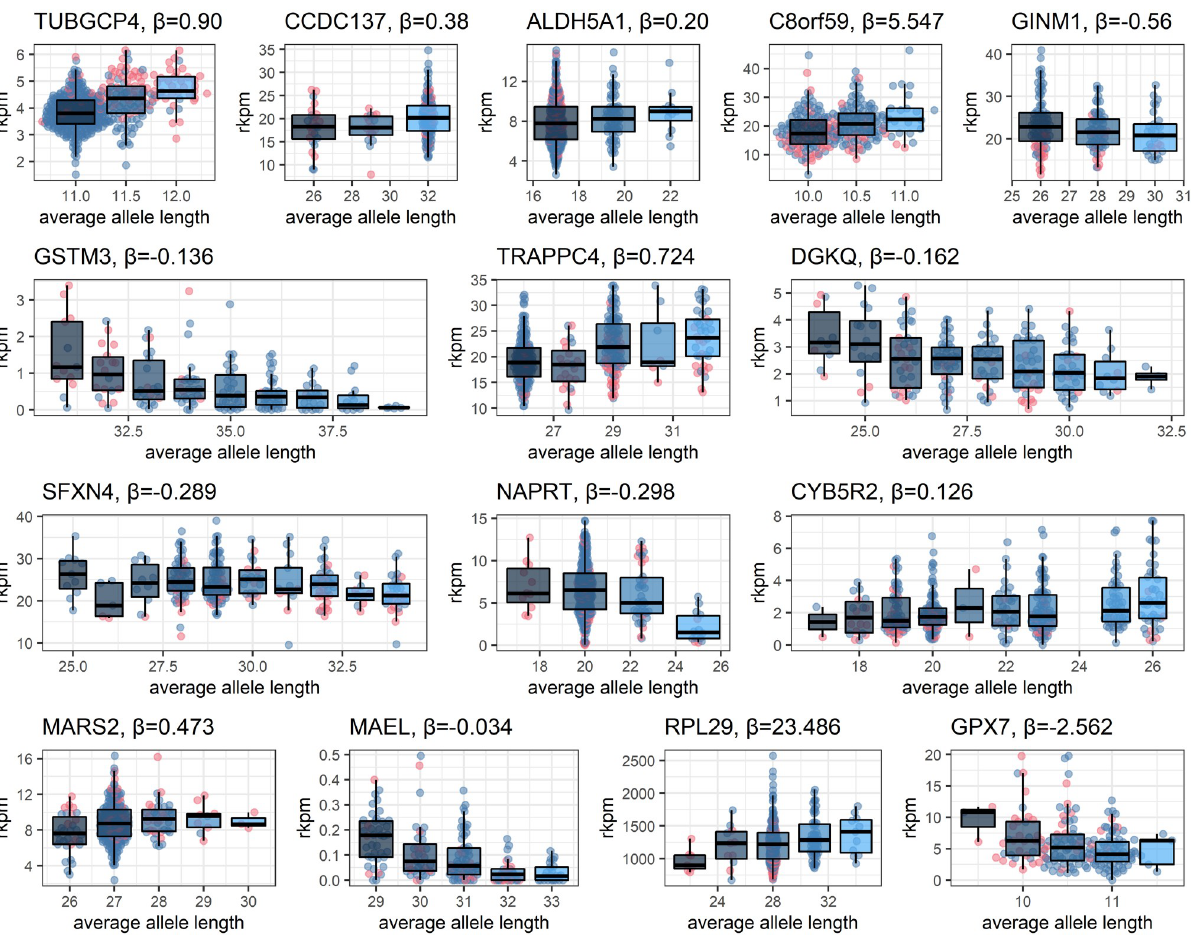
Fig 4. Array length polymorphisms for 15 microsatellites correlate with gene expression. Each gene is associated with an overlapping EBML/eSTR. In each case the null is rejected: no association between repeat length and gene expression. African samples (red) and European samples (blue) visually reiterate that array length polymorphisms are ethnically biased. Enrichment analysis reveals 1 significant KEGG pathway: glutathione metabolism. Genes involved in glutathione metabolism include GSTM3 and GPX7.